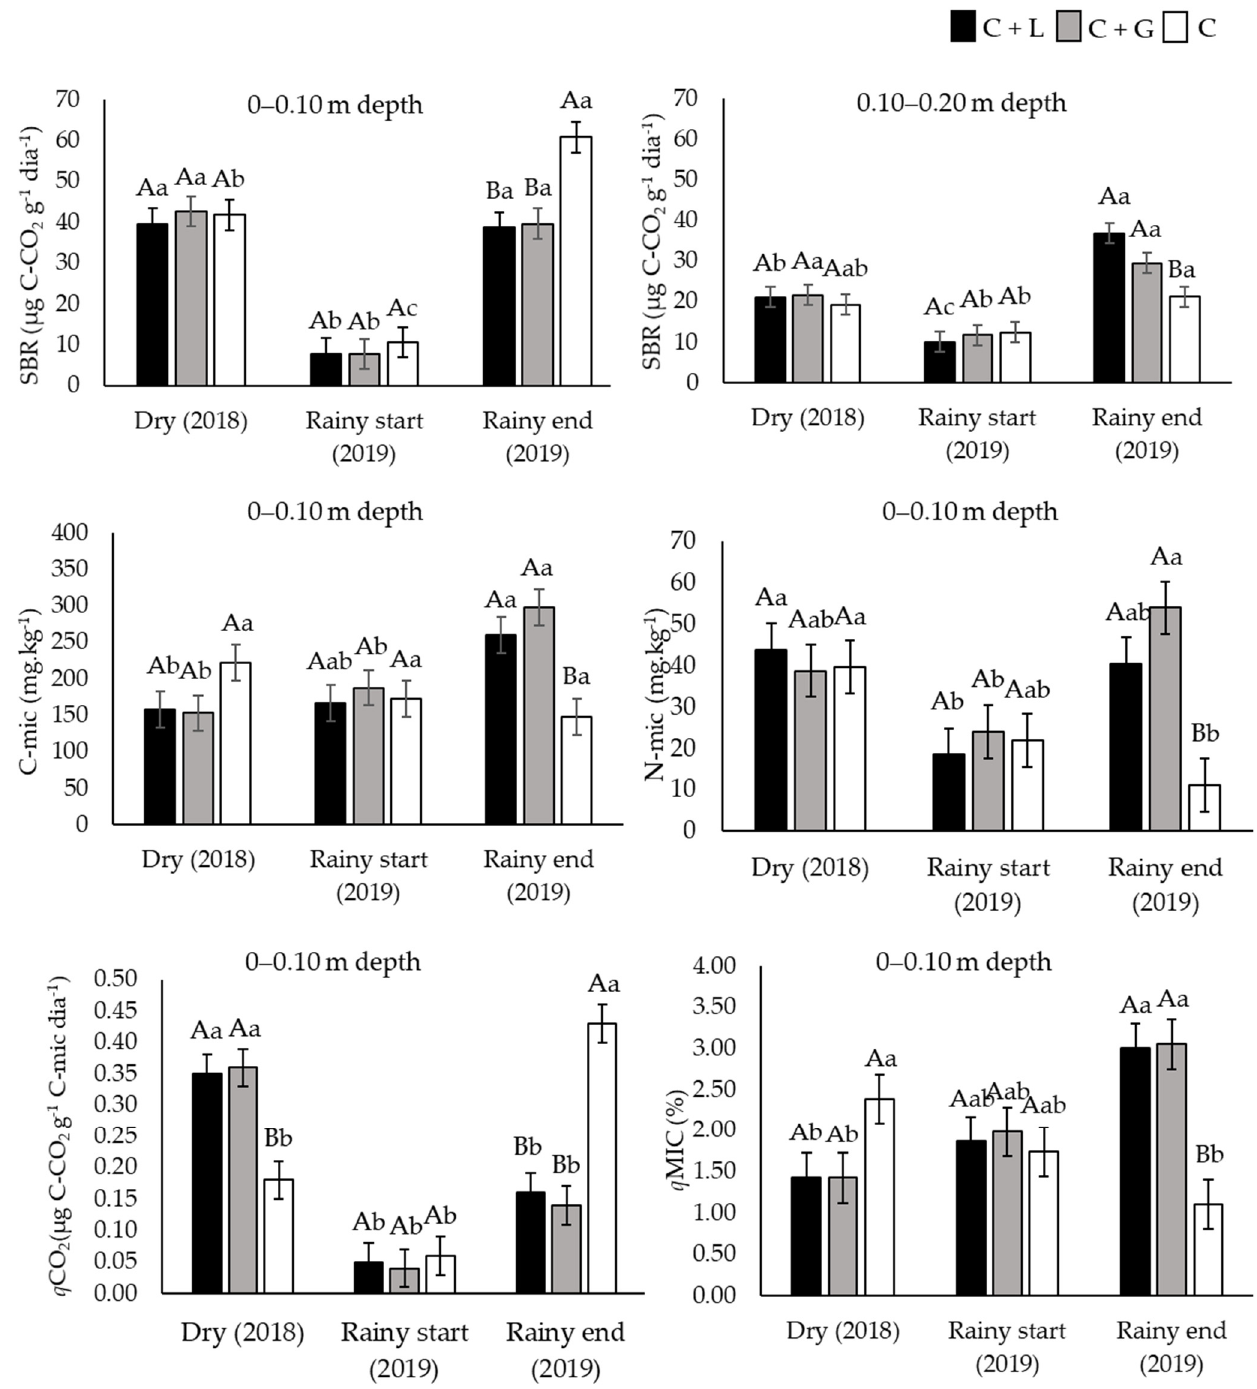
Figure 5. Soil basal respiration (SBR), soil microbial carbon (C-mic), soil microbial nitrogen (N-mic), metabolic quotient ( q CO 2 ), and microbial quotient ( q MIC) in different cactus cropping systems and dates. C + L: cactus + leucaena; C + G: cactus + gliricidia; C: cactus in monoculture. Different capital letters indicate significant difference ( p < 0.10) within each period of the year; different small case letters indicate significant difference within each cropping system ( p < 0.10) by PDIFF adjusted to Tukey. Bars indicate the standard error of the mean.